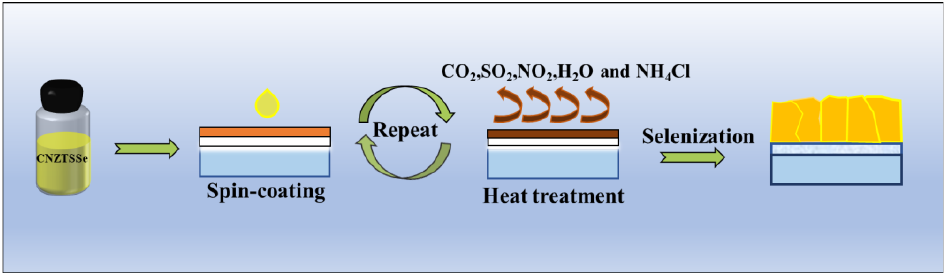
Figure 1. Schematic diagram of CNZTSSe films preparation. To analyze the function of selenization temperature on the grain growth, the curves of 2 θ , peak intensity, and half peak width (FWHM) with respect to selenization temperature were drawn by using the test data of XRD. Along with the selenization temperature increasing, the value of 2 θ gradually decreased, as shown in Figure 3. Meanwhile, the peak intensity gradually strengthens and the corresponding FWHM decreases. At the optimal selenization temperature (540 ◦ C), the peak intensity is the strongest and the FWHM value is minimal. The results show that the film crystallinity is significantly enhanced. The film crystallinity is very important to obtain ideal thin films. Therefore, it is meaningful to adjust the selenization temperature for obtaining high-quality